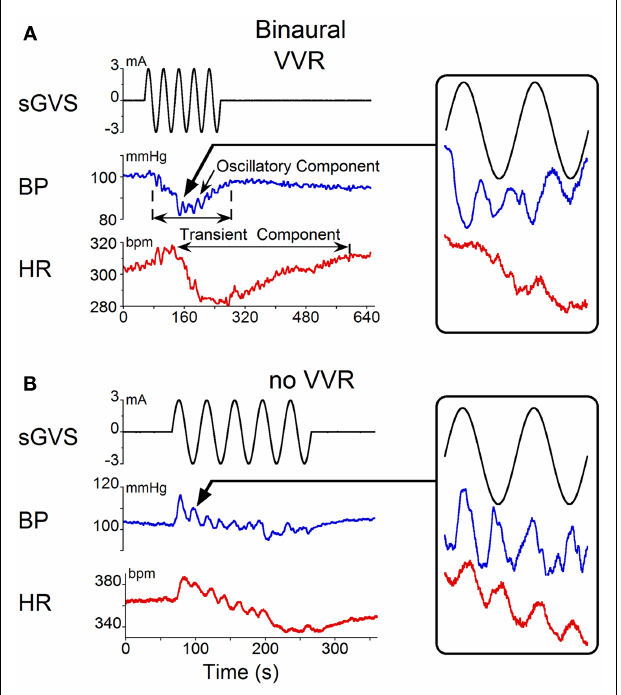
FIGURE 1 | Changes in blood pressure (BP) and heart rate (HR) induced by binaural 3mA sGVS at 0.025Hz . (A) Vasovagal oscillations and a vasovagal response (VVR) induced by sGVS.Top trace is stimulus (black), middle trace is BP (blue), bottom trace is HR (red).The oscillatory component was at twice the stimulus frequency and was present before and during the transient response.The transient component was characterized by a steep drop in BP and HR that persisted for several minutes.The changes in HR were more pronounced than the changes in BP. Inset on the right is an expanded trace of two cycles (80s) of sGVS. Arrow indicates location of the data expanded in the inset. BP and HR in the inset are not scaled, to illustrate oscillations at twice the stimulus frequency. (B) In another experiment, the same stimulus induced oscillations at twice the stimulus frequency in both HR and BP (see inset, showing two cycles of sGVS on an expanded trace).This stimulus induced a slight drop in HR, but no prolonged drop in